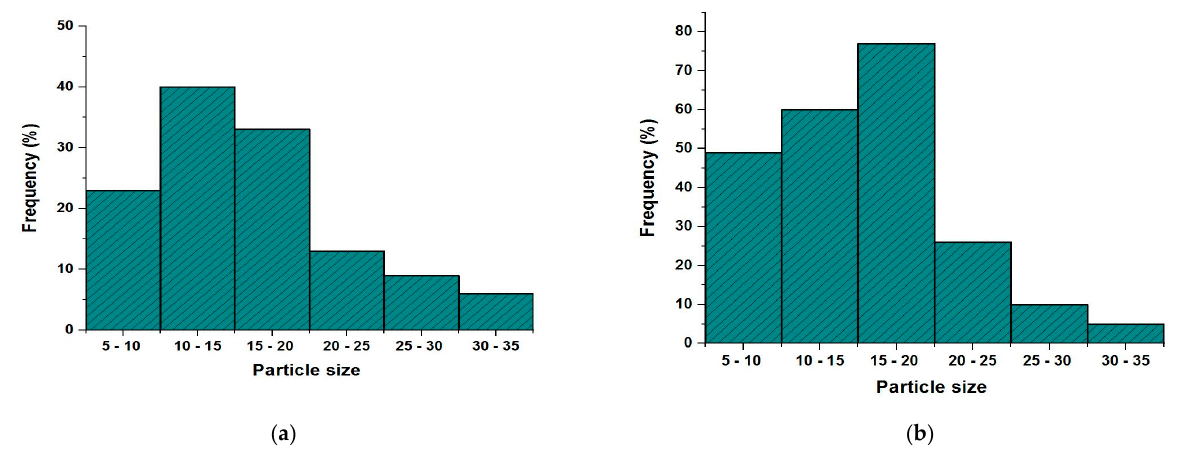
Figure 4. Piratical size distribution of Ulva/nanocellulose ( a ) and Ulva/Ag/cellulose nanocomposites ( b ) derived from U. lactuca .